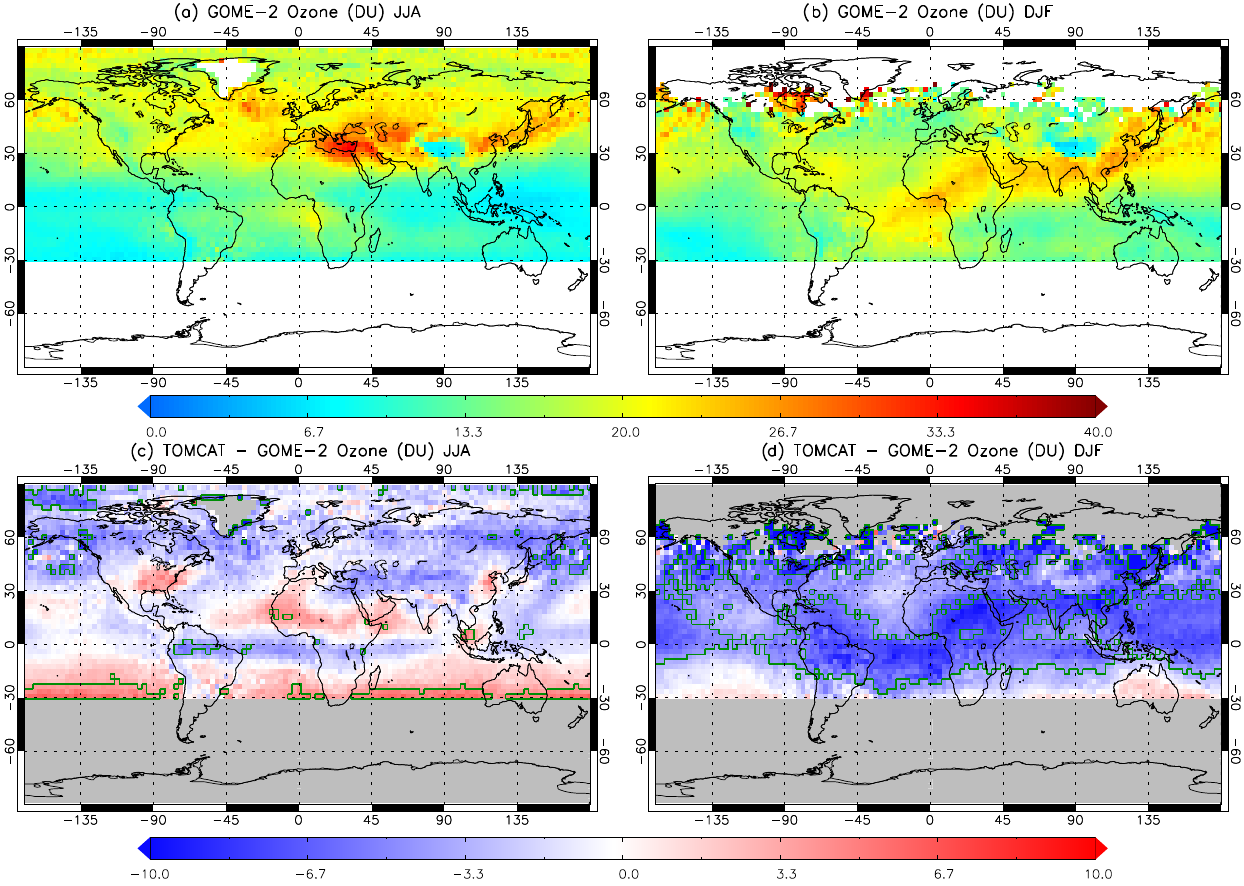
Figure 10. GOME-2 subcolumn O 3 (0–6km, DU) on the TOMCAT 2 . 8 ◦ × 2 . 8 ◦ grid for (a) June–July–August 2008 (JJA) and (b) December– January–February 2008 (DJF). Panels (c) and (d) show the difference in concentrations between TOMCAT and GOME-2. The green polygons indicate where the mean bias (MB) is greater than the satellite